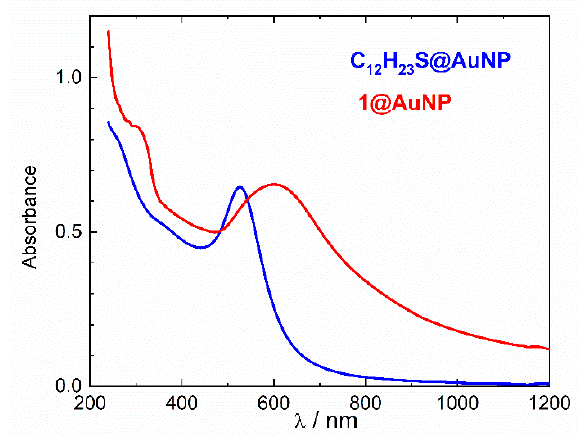
Figure 3. UV-Vis spectra of C 12 H 23 S@AuNPs and 1 @AuNPs in chloroform.